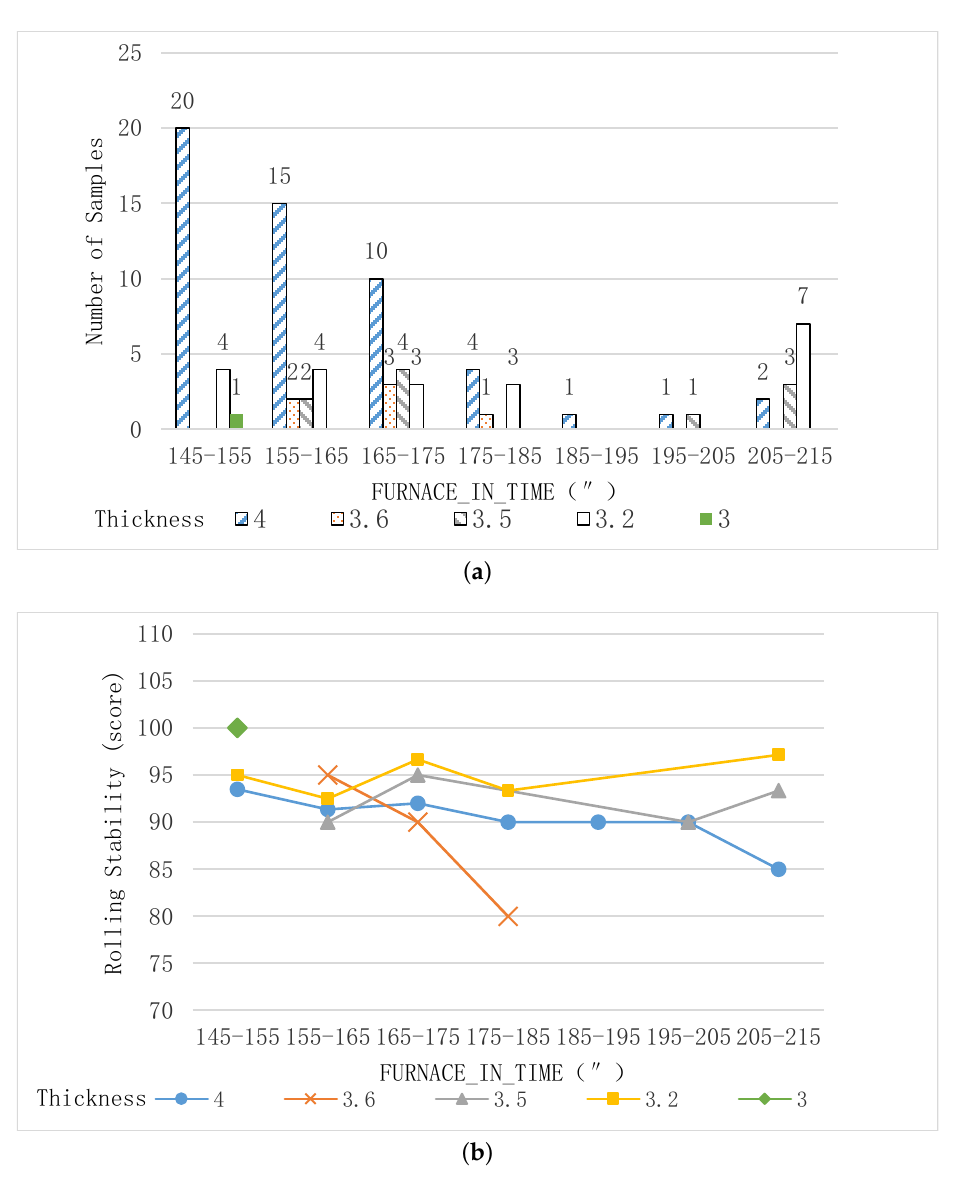
Figure 9. Time in the furnace. ( a ) Sample distribution; ( b ) Stability